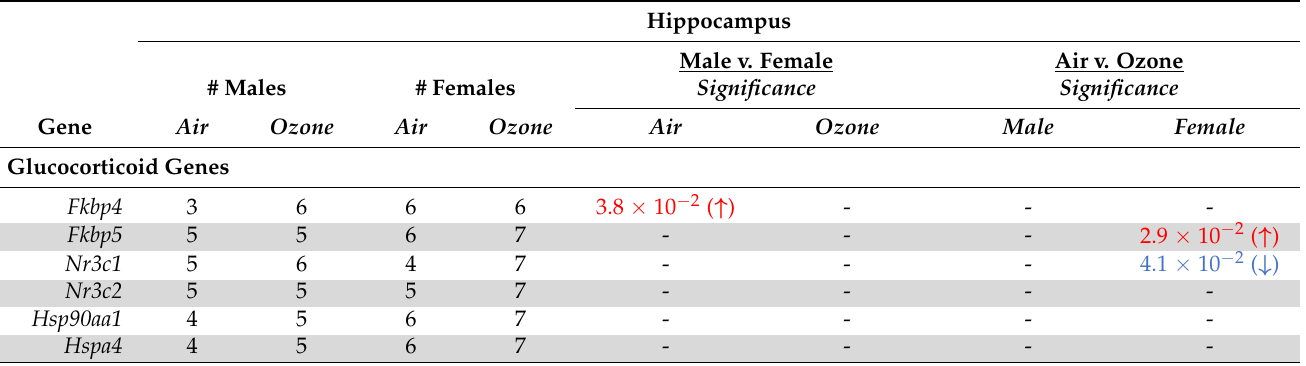
Figure 6. Glucocorticoid Related Gene Expression in the hippocampus (HIP) and hypothalamus (HYP) following ozone exposure in male and female rats. ( A ) Nr3c1 ; ( B ) Nr3c2 ; ( C ) Hsp90aa1 ; ( D ) Hspa4 ; ( E ) Fkbp4 ; ( F ) Fkbp5 expression was assessed using qPCR in HIP and HYP. Data are expressed by boxplots where n = 4–6 after removal of outliers using Tukey’s Interquartile Range (IQR) outlier test. * Represents post-hoc statistical differences where p < 0.05; **** Represents significance at p < 0.0001. Table 1. Significantly Modified Genes Showing Ozone Effects and Sex Dependent